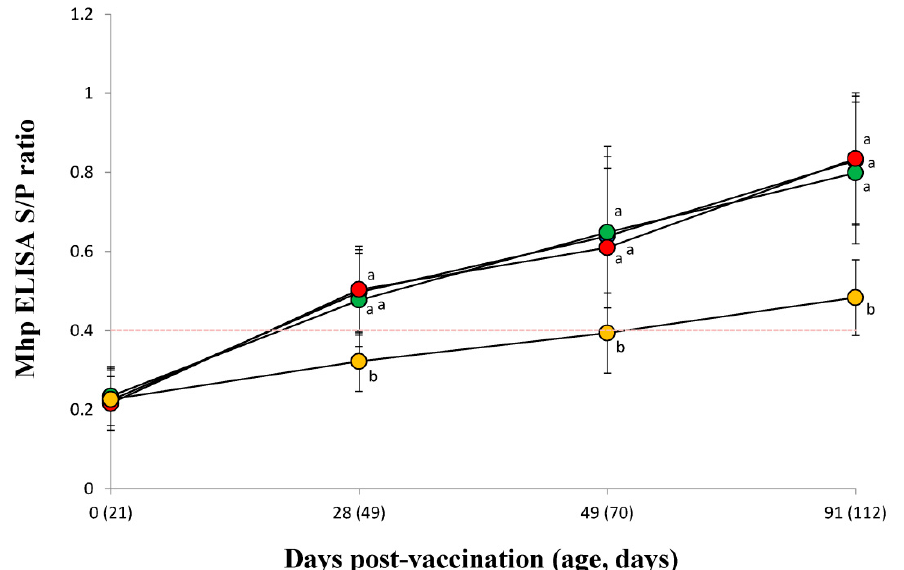
Figure 7. Mean values of the Mycoplasma hyopneumoniae antibodies by enzyme-linked immunosorbent assay (ELISA) in serum from VacS ( • ), VacPulse ( • ), VacEPIG ( • ), and UnVac ( • ) groups. Variation is expressed as the standard deviation. Serum samples are considered positive for M. hyopneumoniae antibodies if the sample-to-positive (S/P) ratio was ≥ 0.4 (red dotted line). Different superscripts (a and b) indicate significant ( p < 0.05) different among 4 groups.